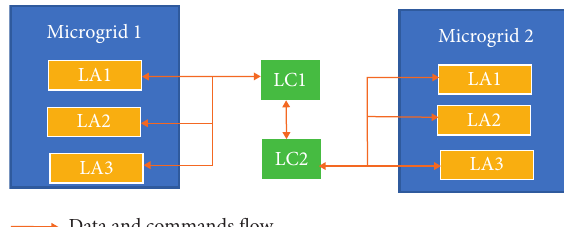
Figure 2: Distributed control architecture. A controller is assigned to each microgrid that can communicate with each other.